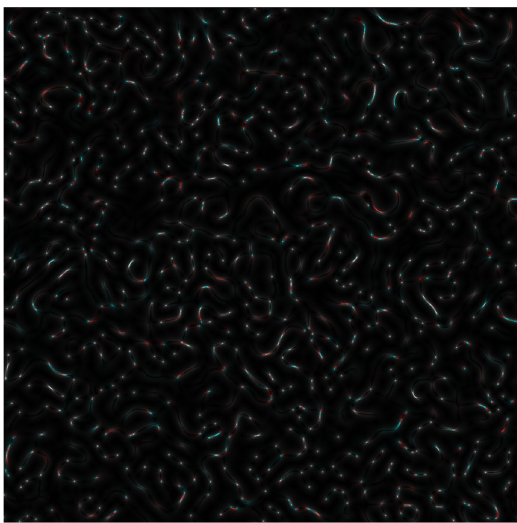
Figure 3a. Coloured s-LASCA images of GB-speckles, generated for three SARS – CoV-2 genes (the gene#1, the gene#2 and the gene#3).